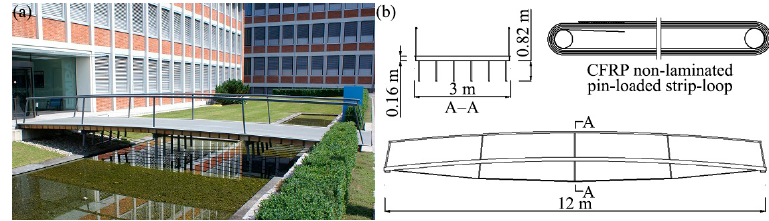
Figure 23. EMPA Bowstring Arch Footbridge, ( a ) photo (photo credit: Urs Meier) and ( b ) sketch.